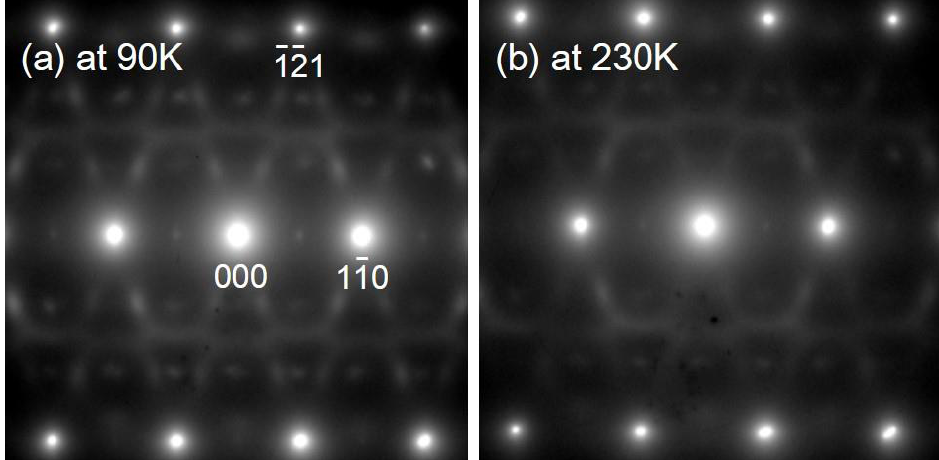
Figure 9. Temperature dependence of diffraction patterns of Zr-18 at.%Nb alloy: ( a ) taken at 90 K and ( b ) taken at 230 K.